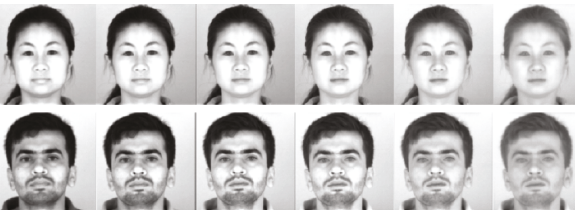
Figure 1: Selected single-band images of two subjects.